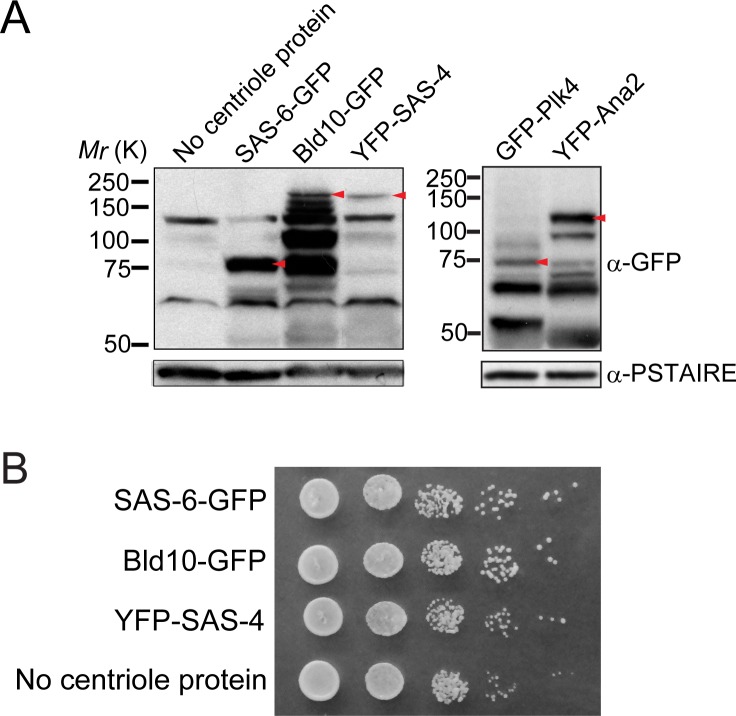
Expression of Drosophila centriole proteins in fission yeast and the growth of fission yeast strains.(A) Western blotting analysis of the protein extracts prepared from the strains used in Figure 2A. Each red arrowhead indicates the bands with the expected size of the fusion protein. Note that we found that Bld10-GFP was degraded in the cell lysate. It is possible that larger-sized foreign proteins are targeted by fission yeast proteases. (B) Serial dilution assay of the cells expressing indicated Drosophila centriole components under control of the constitutive atb2 promoter, which is shown in Figure 2A. Note that all the strains expressing centriole proteins grew similarly as the control (no centriole protein).